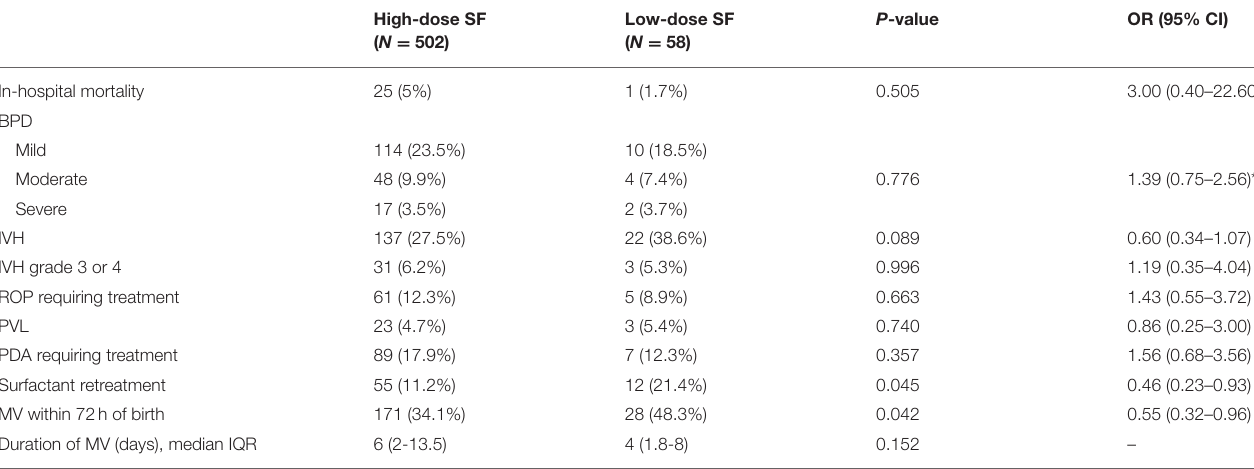
TABLE 5 | Outcomes comparison in the high- and low-dose groups.